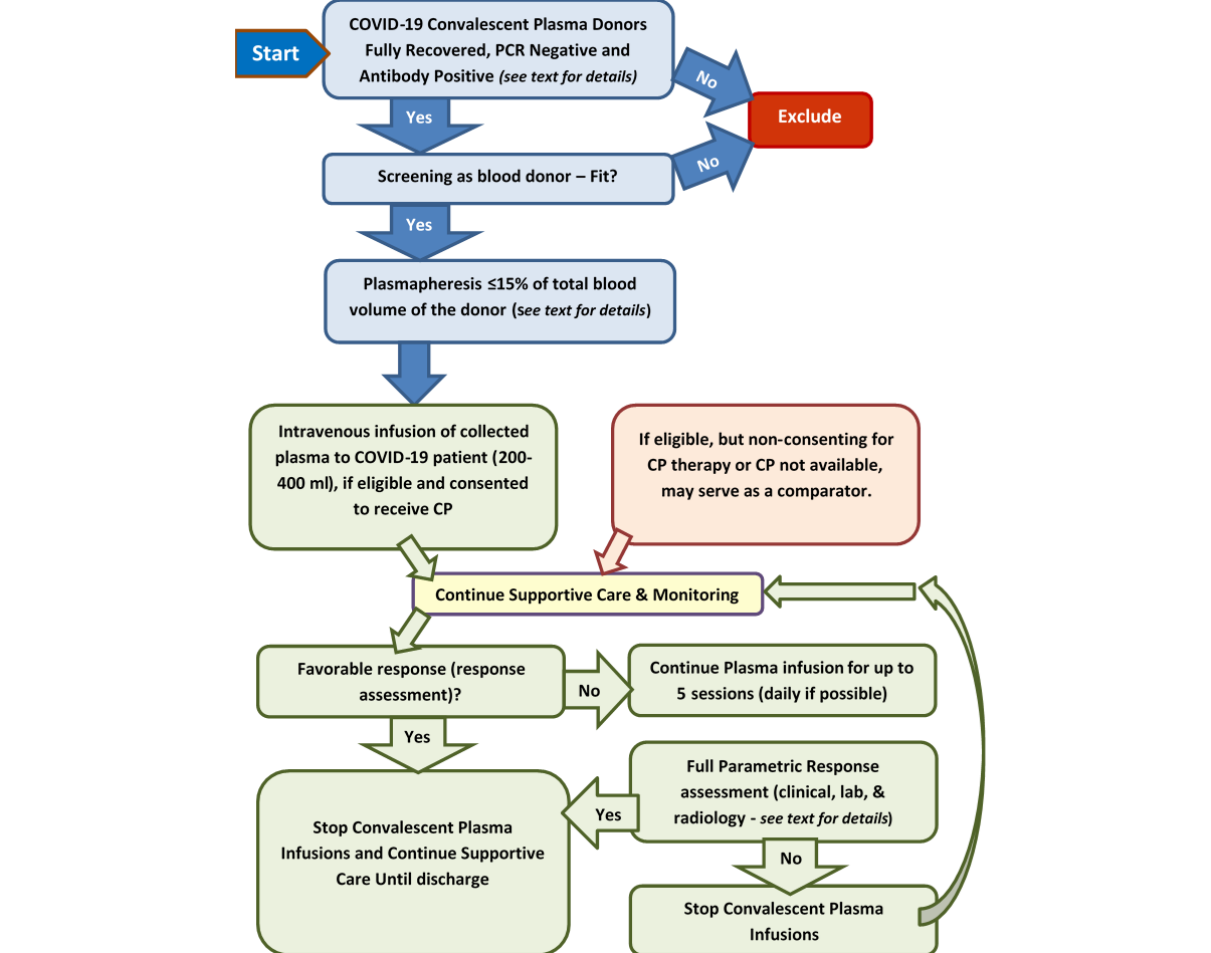
Figure 3. Schematic for the proposed process of CP donation and infusion. CP: convalescent plasma; PCR: polymerase chain